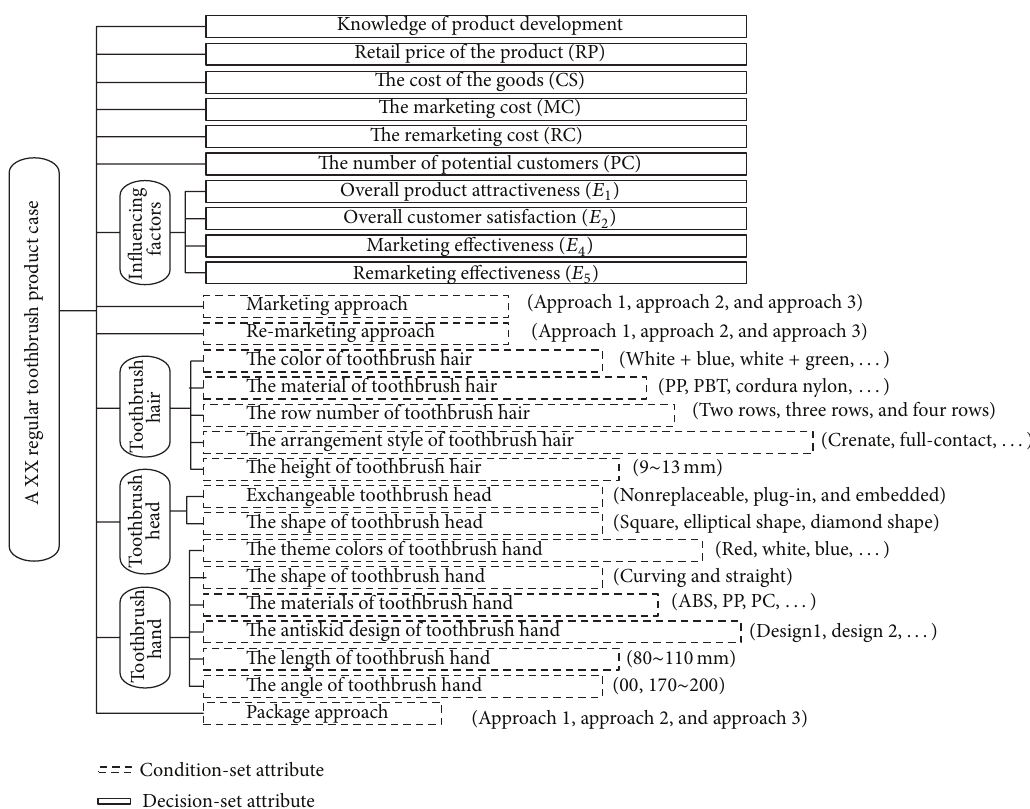
Figure 8: The frame representation of a regular